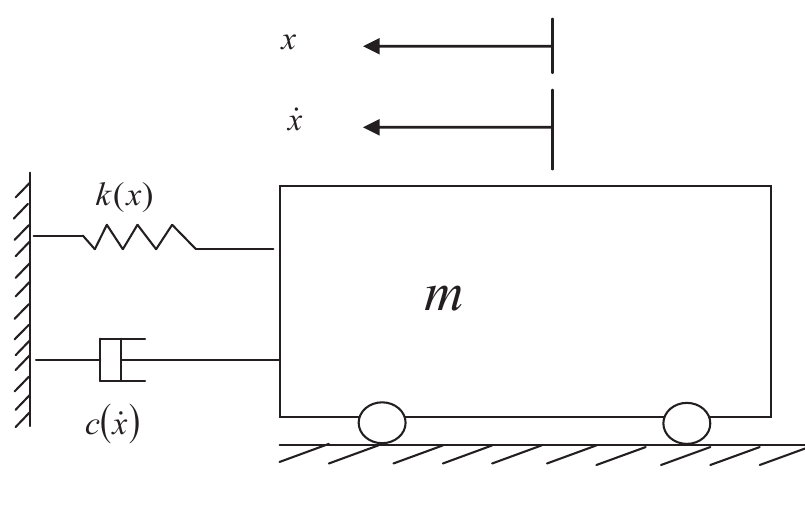
Figure 3. Lumped parameter